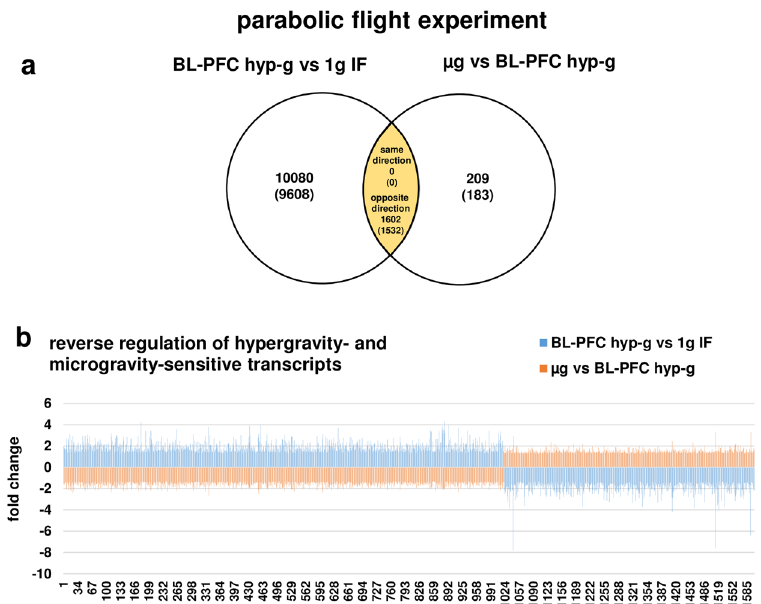
Figure 5. Hyper- and microgravity-double-sensitive transcripts were reversely regulated in the 19 th DLR Parabolic Flight Campaign. ( a ) Venn diagram showing 1602 hyper- and microgravity-double-sensitive transcripts (1532 annotated transcripts). ( b ) Graphical display of the 1602 transcripts of the intersection. Fold changes (FCs) are ratios between the averages of linear expression values. If the ratio is < 1, FC is calculated as the negative reciprocal of the